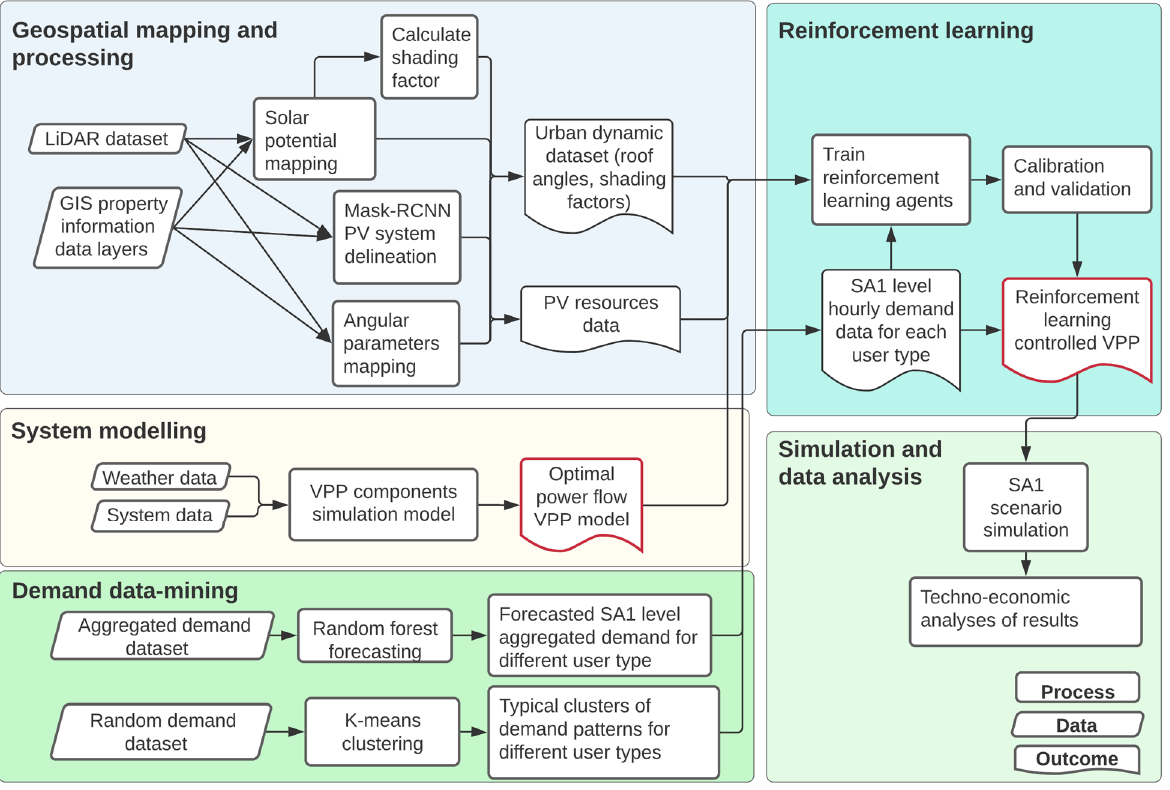
Figure 2. Summary of the research process.